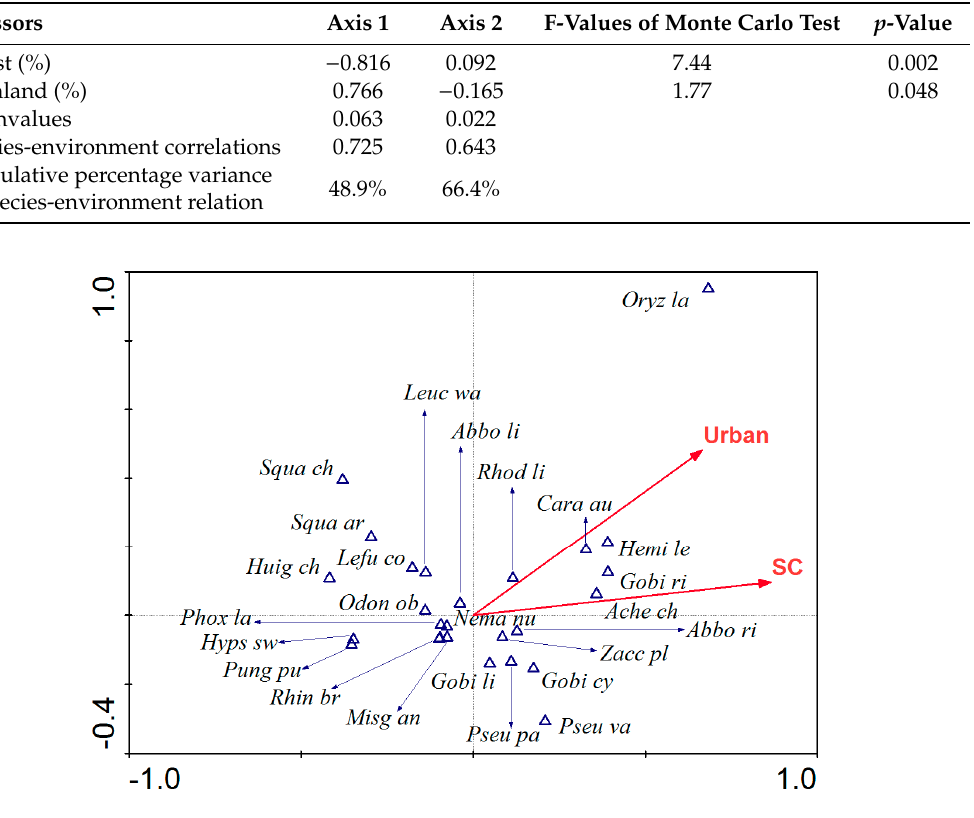
Table 4. Monte Carlo unrestricted permutation test of stressors and fish functional structure in pCCA.